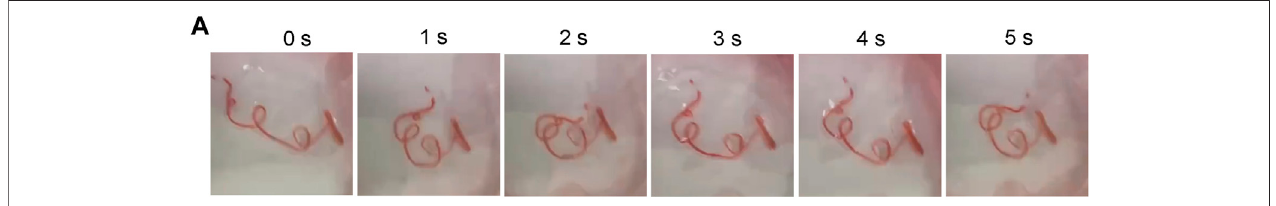
FIGURE 9 | Periodic Movement of Microtubes in vitro (A) Microtubules perform a periodic movement on a shaker real-time Image of Movement Status within 5 s.